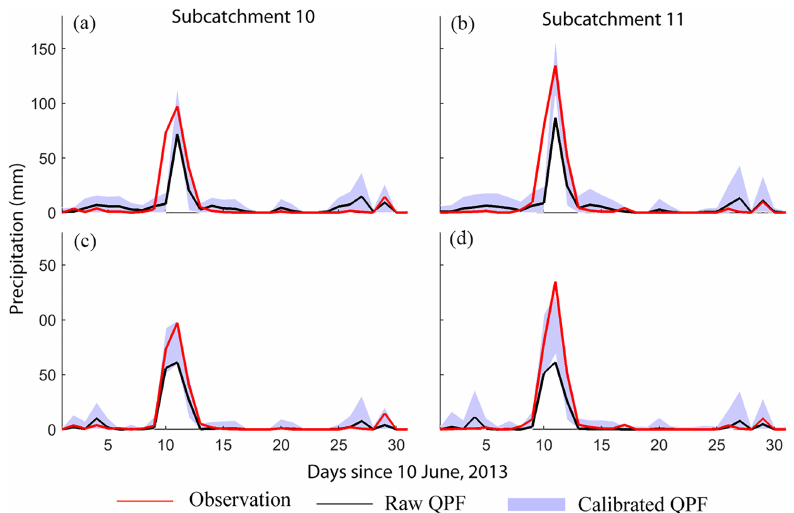
Figure 7. Comparison of time series of precipitation obtained from subcatchment-averaged raw QPFs, subcatchment-averaged observations, and subcatchment-averaged calibrated QPFs in subcatchments 10 and 11. The shaded area represents the range of values obtained from 1000 post-processed ensembles. Panels (a) and (b) show results of calibrated GEFS, and panels (c) and (d) show results of calibrated GDPS.